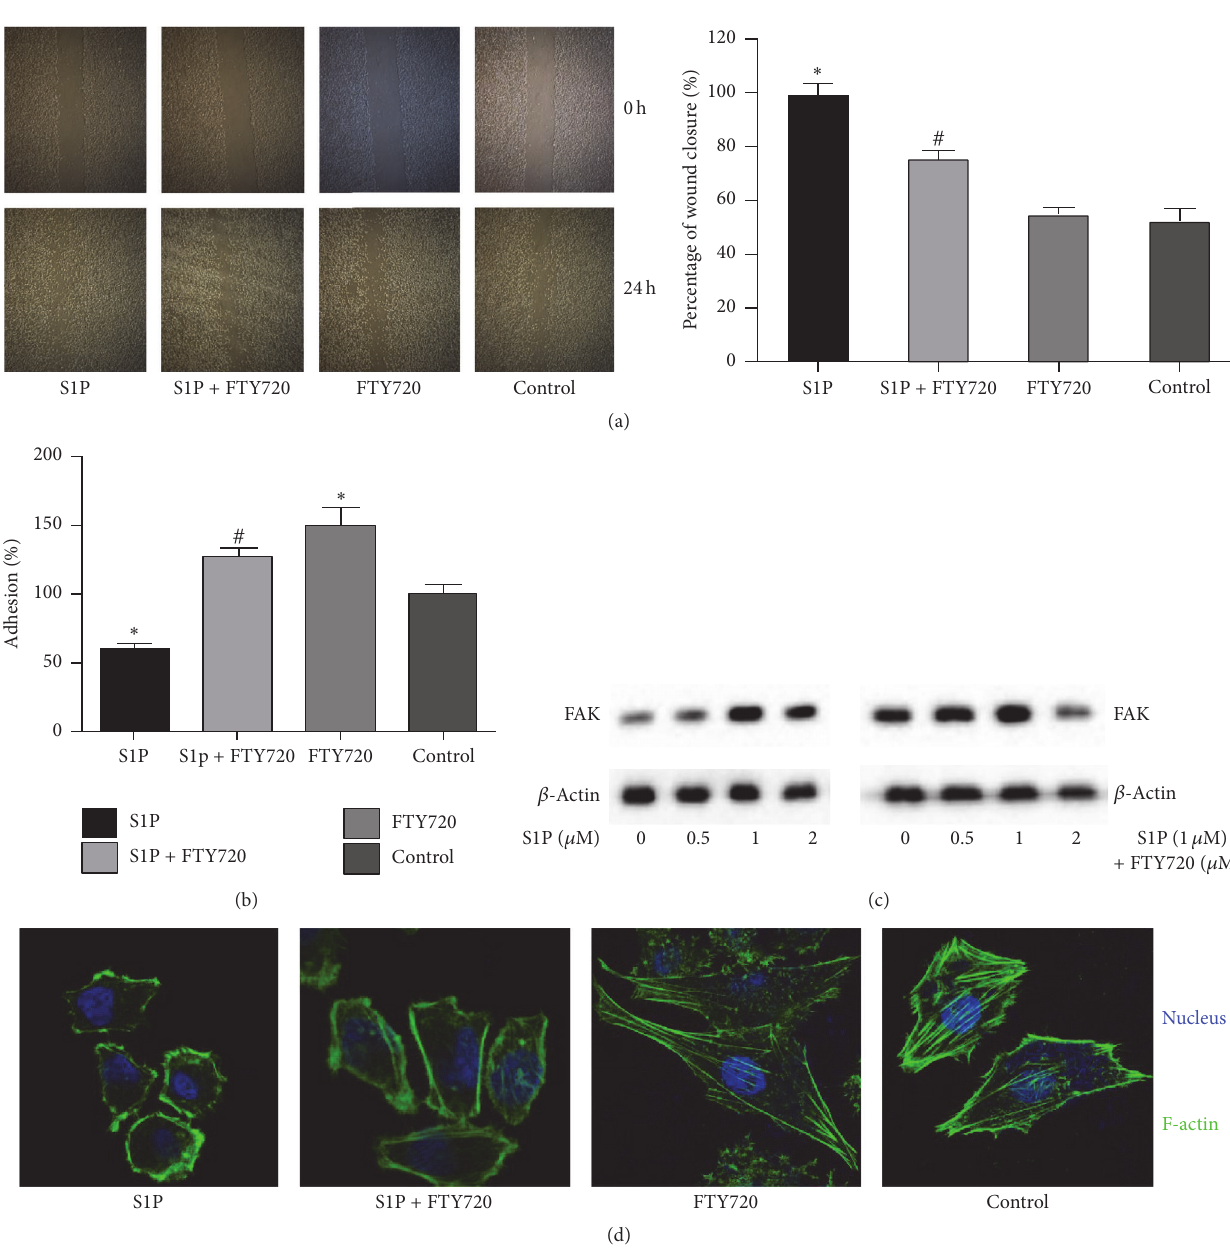
Figure 4: FTY720 could alleviate exogenous S1P-induced podocyte damage. Immortalized murine podocytes were cultured. Using 5 𝜇 M FTY720 pretreated for 30 min, followed by S1P treatment (2 𝜇 M) for 24 h. Using different doses of S1P within 0 ∼ 2 𝜇 M S1P treated podocyte for 24 h. Or using 5 𝜇 M FTY720 treated for 24 h. Podocyte migration was measured by using wound-healing assay. Podocyte migration was measured by using adhesion assay and measured by MTT assay for adhesion cells in plate. FAK protein expression level in rat plasma was detected by western blot. 𝛽 -Actin was used to ensure an equal amount of protein was loaded in each lane. Data represented is the means ± SD of six independent experiments performed in triplicate. Immunofluorescence was used to observe F-actin change. Three independent experiments were performed. Results are presented as mean cell migration velocity ± SD of the independent experiments, ∗ 𝑃 < 0.05 , versus controlpodocyte; # 𝑃 < 0.05 ,versusS1Ptreatedpodocyte.(a)Themigrationabilityofpodocytecellswasmeasuredusingwound-healingassay. The percentage of wound closure was significantly reduced in response to treatment with either S1P or FTY720. Podocyte was treated with S1P which showed a higher cell migration velocity than FTY720-treated or control cells. Podocyte pretreated with FT720 and then treated with S1P showed a slower migration velocity than S1P treated podocyte. (b) The adhesion ability of podocyte cells was measured using adhesion assay. (c) FAK protein expression level in rat plasma was detected by western blot. (d) Representative confocal microscopy images from 3 separate experiments of podocyte cells were treated with S1P or FTY720 for 24 h. F-actin (stained with phalloidin): green; and nuclei: blue. Original magnification ×